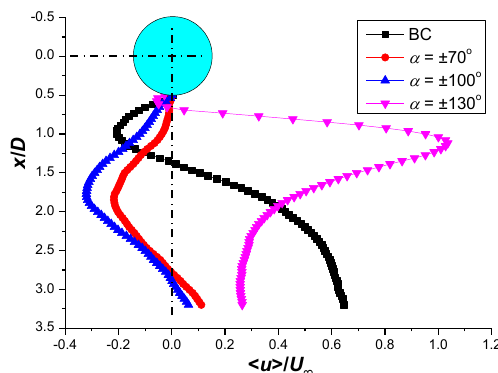
Fig. 5. Variation of < u >/ U ∞ along the wake centerline for the BC, A70, A100 and A130 cases.